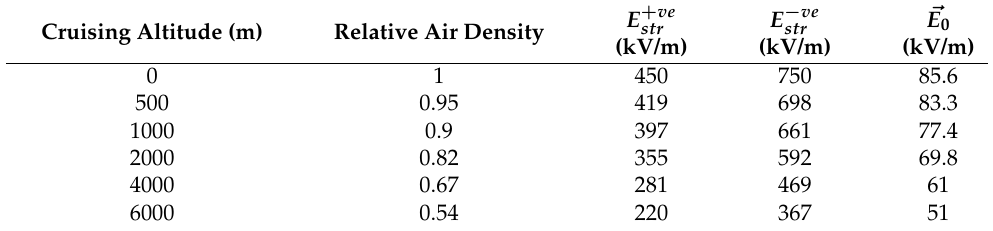
Table 4. Minimum ambient field required for stable bi-polar leader inception (inception locations and direction of ambient field are same as Case-A of Table 1) from a cruising aircraft with air- density correction for streamer gradients ( E + ve humidity—5 gm/m 3 for all the